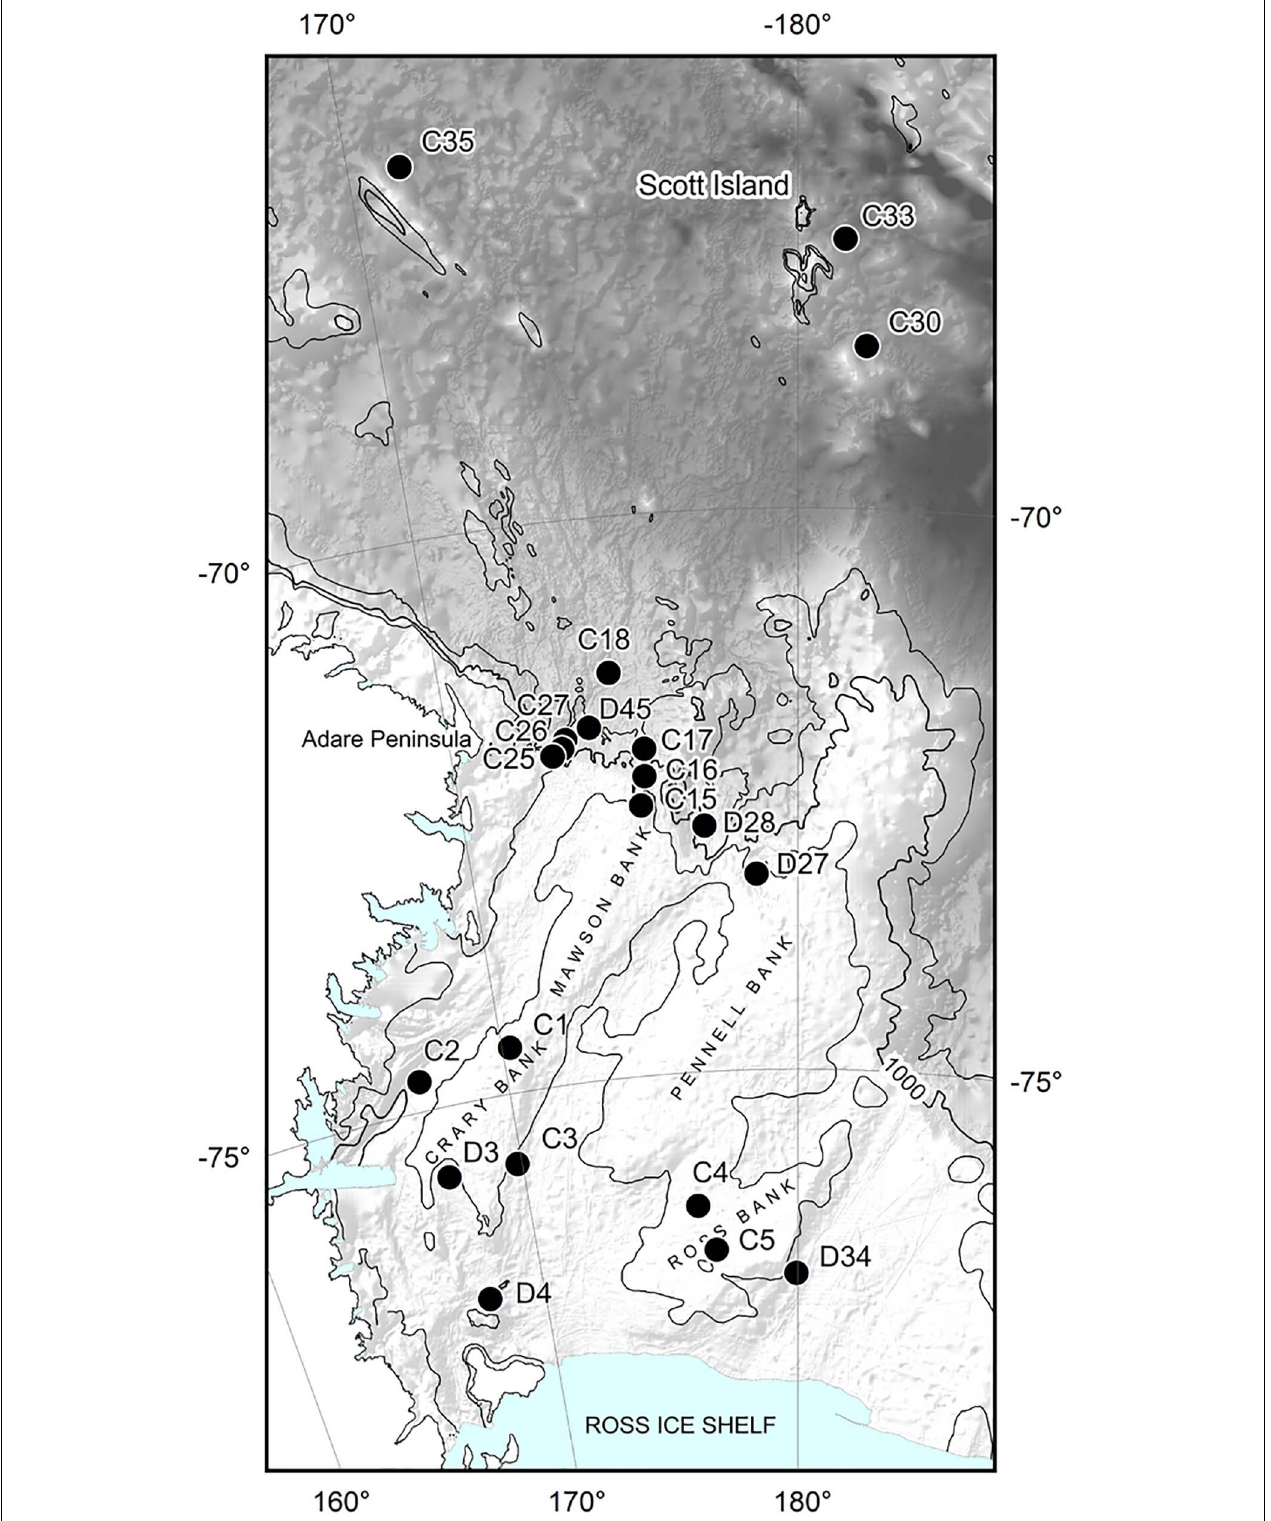
FIGURE 1 | Sites sampled for benthic invertebrates during the NZ IPY-CAML voyage to the Ross Sea (TAN0802) in Jan-Apr 2008. C prefix sites: towed camera, beam trawl, and multicorer; D prefix sites: towed camera and beam trawl only. Hill shade bathymetry from IBSCO v1, isobaths at 500, 1000, and 2000 m.